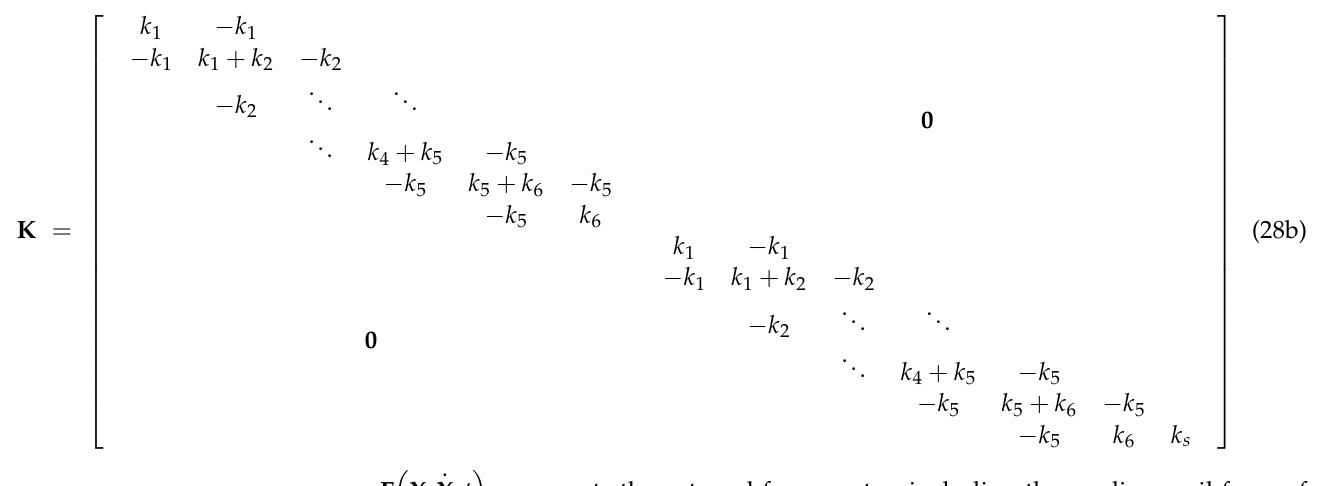
(cid:16) (cid:17) . F X , X , t represents the external force vector, including the nonlinear oil force of the left and right journal, eccentric excitation of each disc and gravity, the expression is shown as: